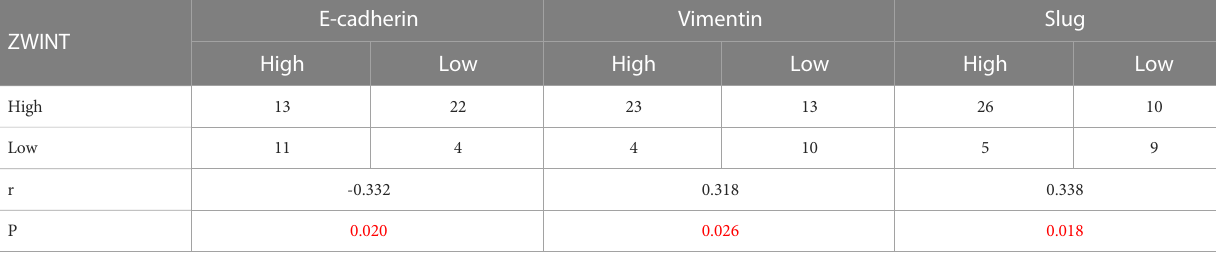
TABLE 3 Protein expression of ZWINT in NSCLC and paracancer tissues (%). Protein expression levels of ZWINT c 2 p Group N High(%) Low(%) NSCLC 50 36(72%) 14(28%) 34.313 0.000 Para cancer 50 7(14%) 43(86%)